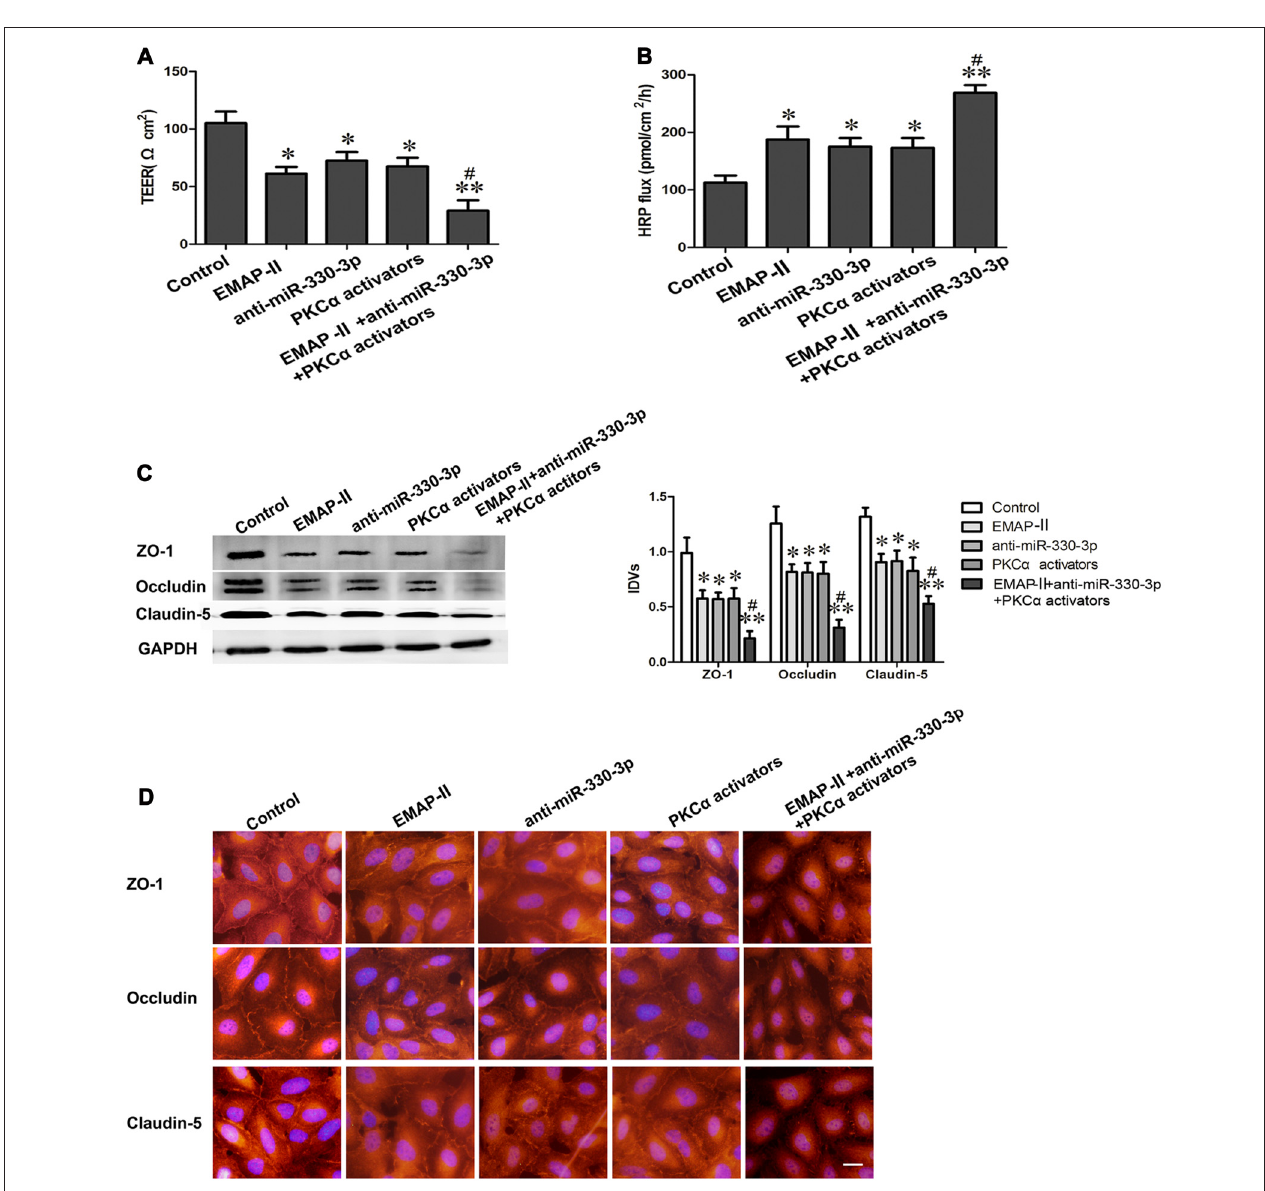
FIGURE 6 | EMAP-II combined with anti-miR-330-3p and PKC α activator increases BTB permeability and the expression levels of TJ related proteins in GECs. (A,B) TEER and HRP assays were used to measure the permeability of BTB. (C) The protein expression levels of ZO-1, occludin and claudin-5 were determined by Western blot. GAPDH was used as an inner control. Values are means ± SD ( n = 5, each). ∗ P < 0.05, ∗∗ P < 0.01 vs. control group; # P < 0.05 vs. EMAP-II group. (D) The expression and distribution of ZO-1, occludin and claudin-5 in GECs was analyzed by immunofluorescence assay. Scale bar represents 20 µ